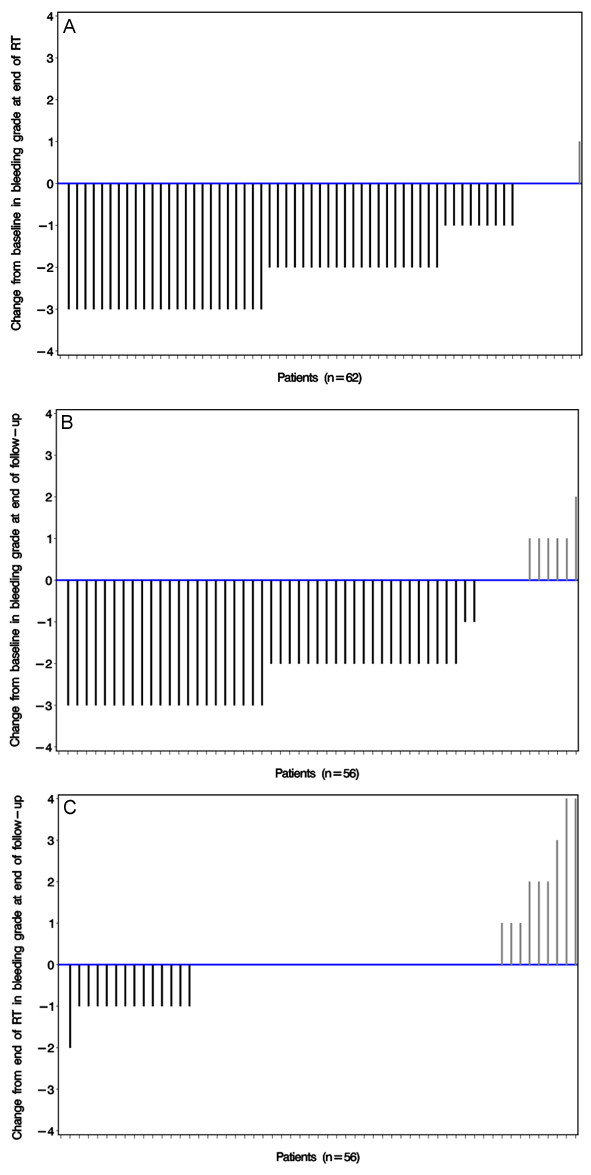
Waterfall plot showing change in bleeding grade at end of RT as compared to baseline (A), change in bleeding grade at end of follow-up as compared to baseline (B) and change in bleeding grade at end of follow-up as compared to at end of RT (C), <0 = Improvement; 0 = Stable (no change); >0 = Worsened.